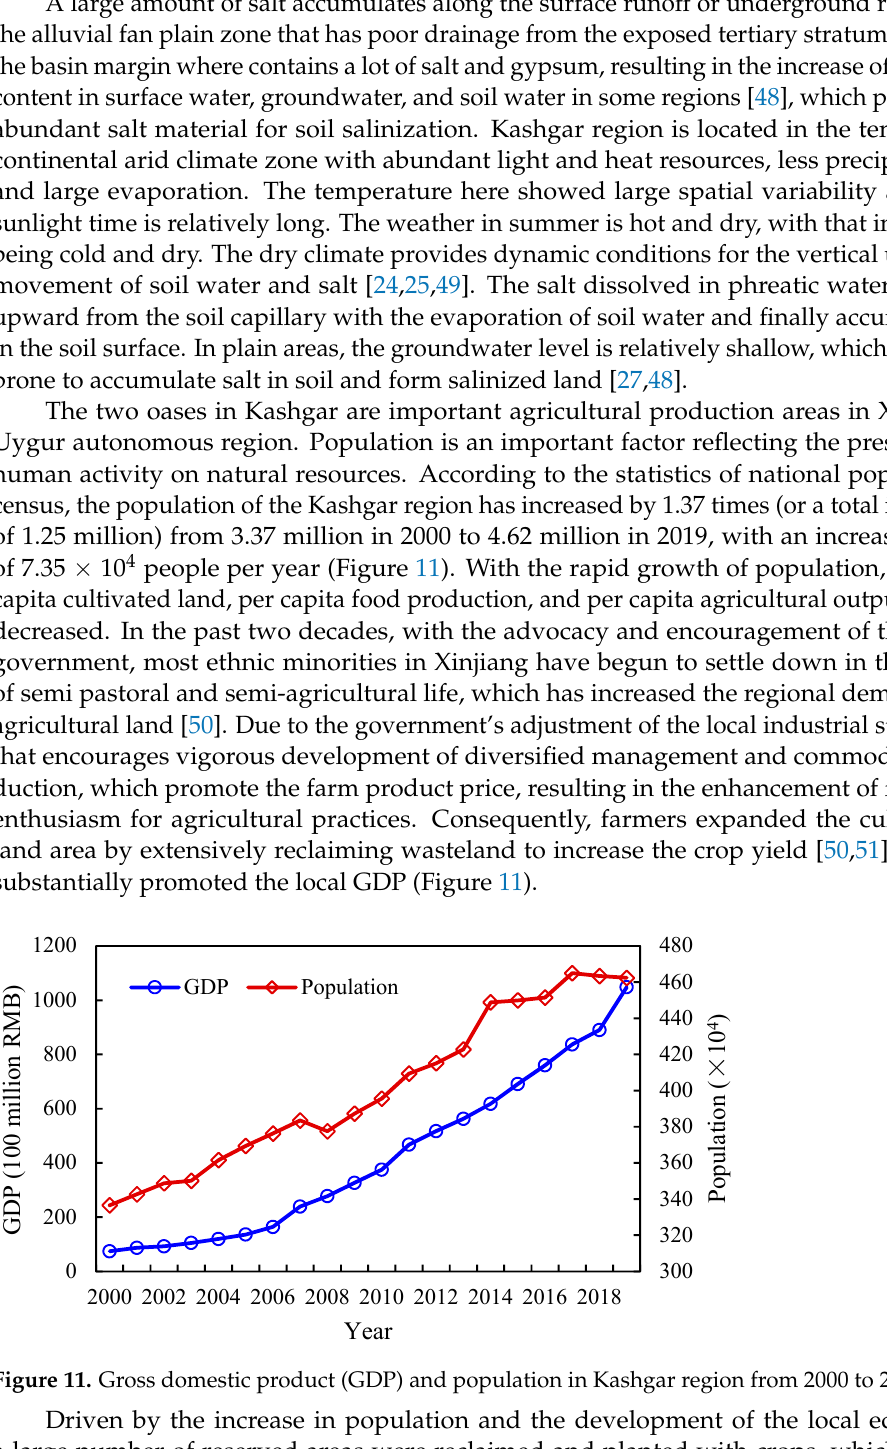
Figure 10. Linear relationships between the variations of soil salinization indicators (salinization severity and salinized soil area) and eco-hydrological parameters. ( a ) ET, ( b ) LST, ( c ) NDVI, ( d ) SM, ( e ) TWSA, ( f ) accuracy validation of the multiple linear regression model.